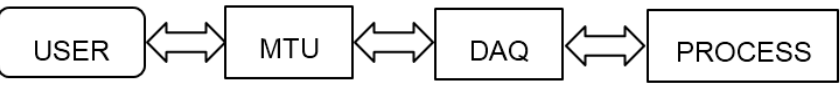
Figure 1. Block diagram of general monitoring system based on DAQ system and MTU.